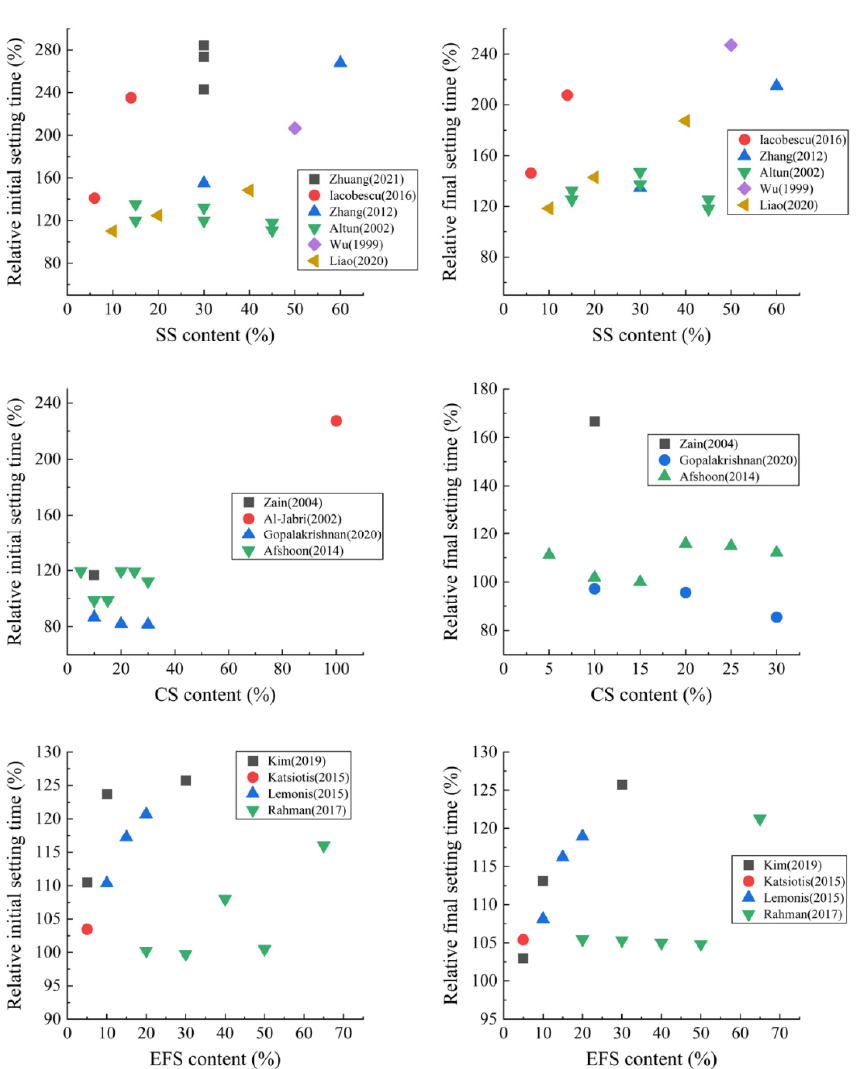
Figure 1. Relative setting time of composite paste containing SS, CS, and EFS. Date from: (1) SS [13,75,79–82]; (2) CS [76,77,83,84]; (3) EFS [70–72,78]. The relative setting time is the ratio of the set ‐